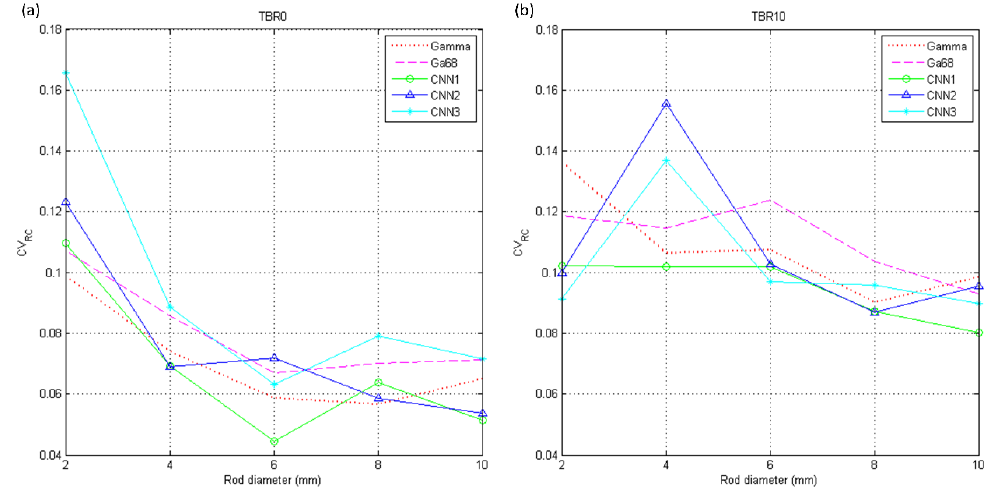
Figure 7. CV RC of I